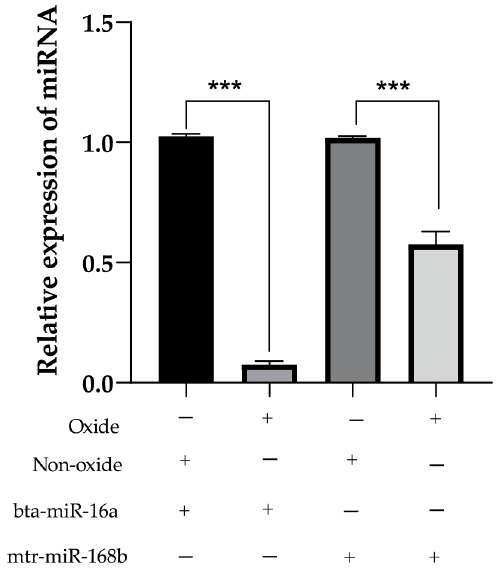
Figure 4. Detection of endogenous and exogenous miRNA expression levels in bovine blood before and after oxidation. Data are given as the mean ± SD for n = 3/group. ** p < 0.01 was considered statistically significant.